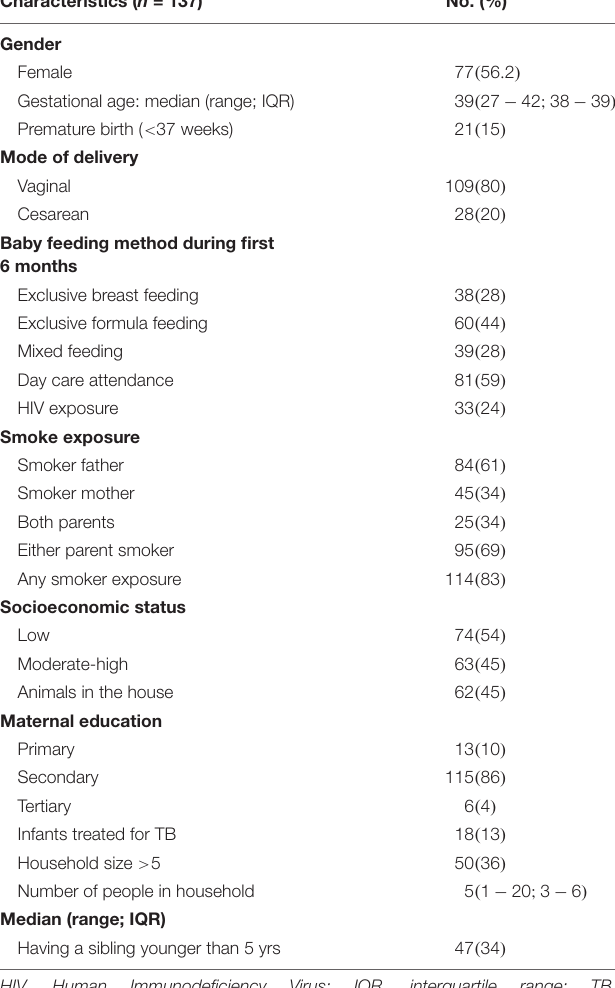
TABLE 1 | Participant